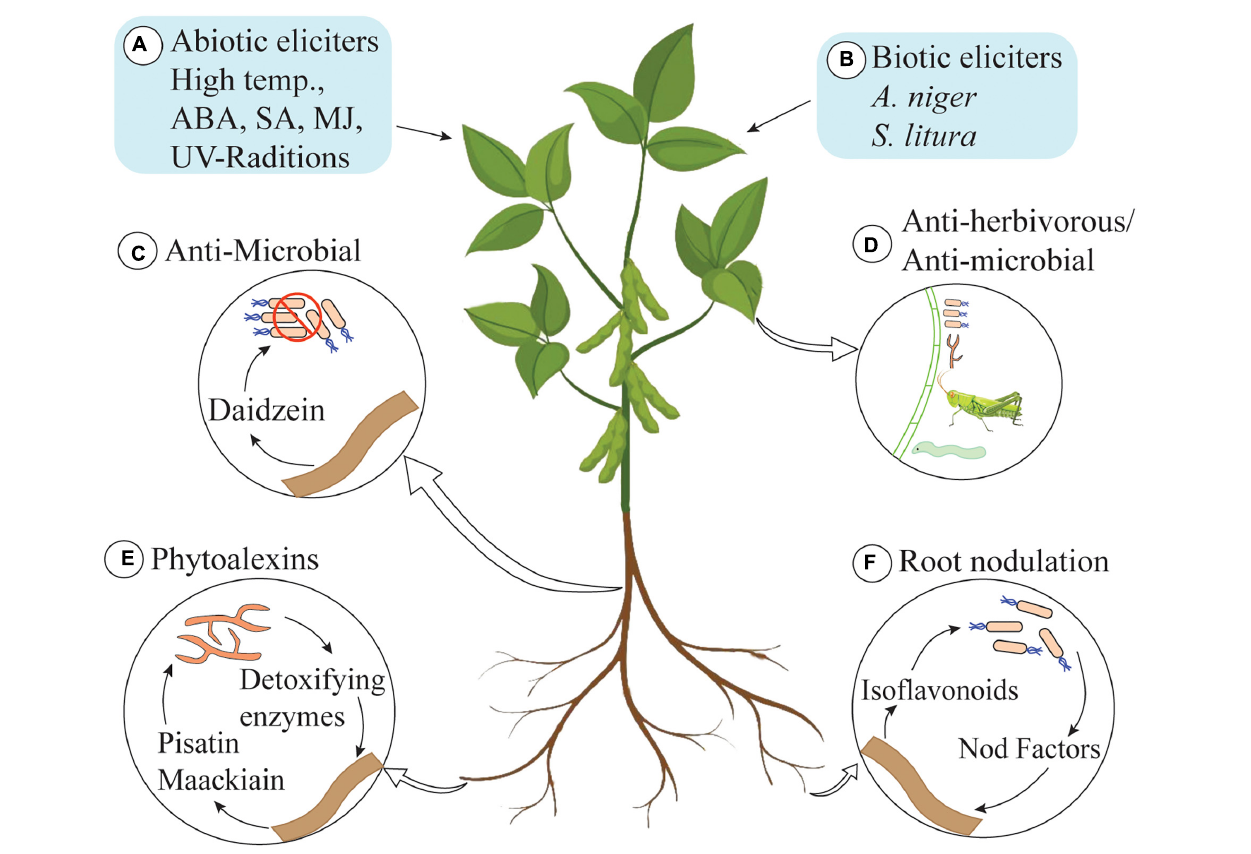
FIGURE 2 | Role of isoflavonoids in plants. (A) Abiotic elicitors: high temperature, abscisic acid (ABA), salicylic acid (SA), methyl jasmonate (MJ), and UV-radiations. (B) Biotic elicitors: Aspergillus niger and Spodoptera litura trigger isoflavonoid biosynthesis in plants. (C) Daidzein secreted by roots kills bacteria in rhizosphere and shapes the rhizosphere communities. (D) Isoflavonoids also possess anti-herbivorous and antimicrobial activities. (E) Pisatin and maachiain kill pathogenic fungi in rhizosphere (some fungi produce detoxifying enzymes to degrade pisatin and maachiain to cause infection in roots of host plant). (F) Some isoflavonoids induce nodulation genes in receptive bacterial species and play an important role in root-nodule